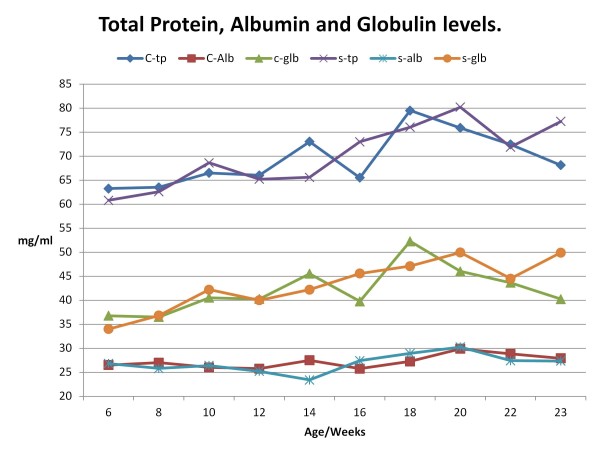
Serum levels of total protein, Albumin and calculated Globulin in both groups from 6 to 23/24 weeks of age. Total protein level in control group (♦ blue) and scrapie group (× purple), Globulin levels for control group (▴ green) and scrapie group (● orange), and albumin levels for control group (■ red) and scrapie group (∗ turquoise). Each time point is presented as the mean values for each group at each time of sampling.